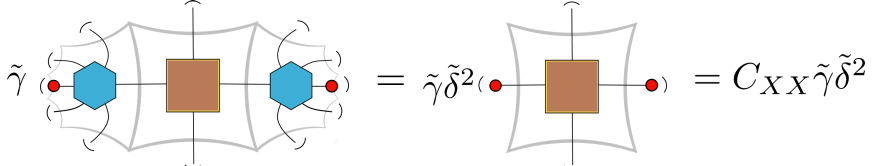
Figure 47. Tensor contraction for two-point function with operator insertions shown in figure 46. The arc denotes tensor contraction. ˜ δ 2 because of the double copy.